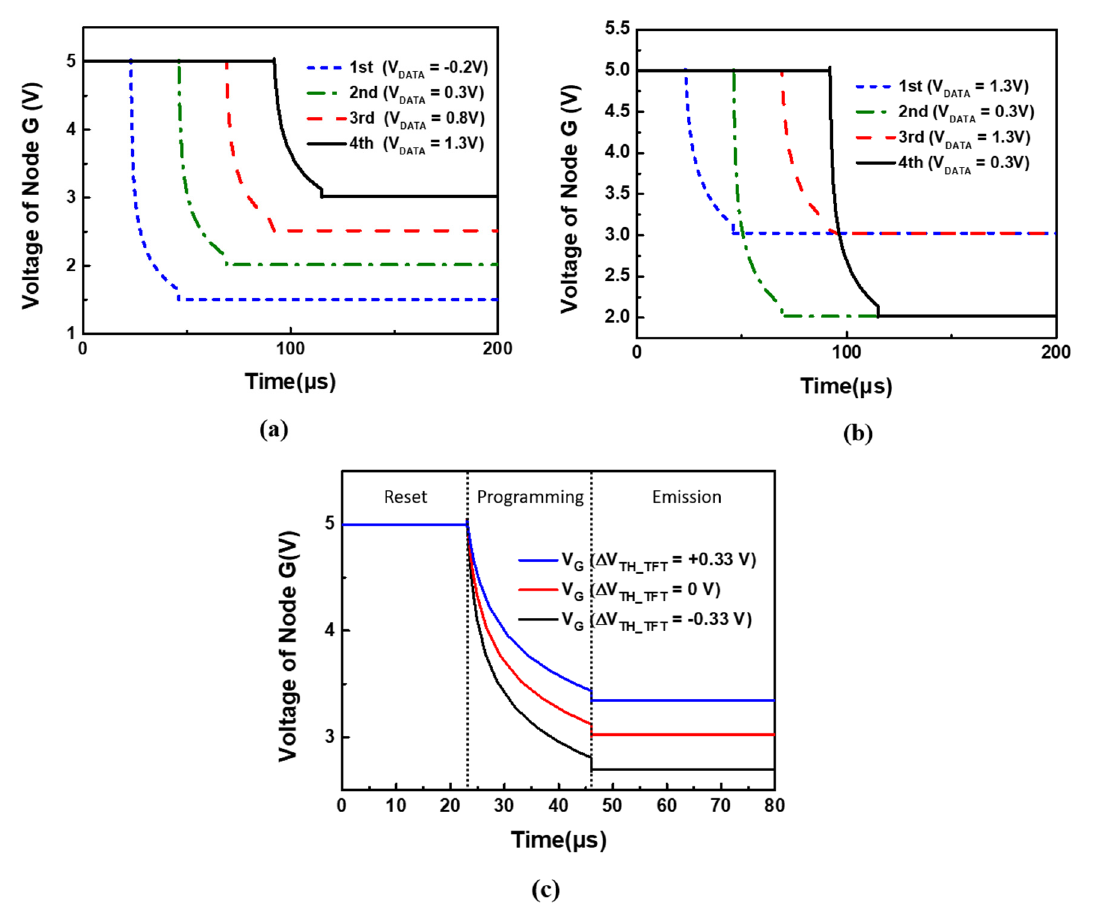
Figure 4. ( a ) Transient waveforms of V G with first row to fourth row in different V DATA . ( b ) Transient waveforms of V G with V DATA = 1.3 V for first row and third row, V DATA = 0.3V for second row and fourth row. ( c ) Transient waveforms of V G for the presented compensation pixel circuit with ± 0.33 V variation in V TH_DTFT .